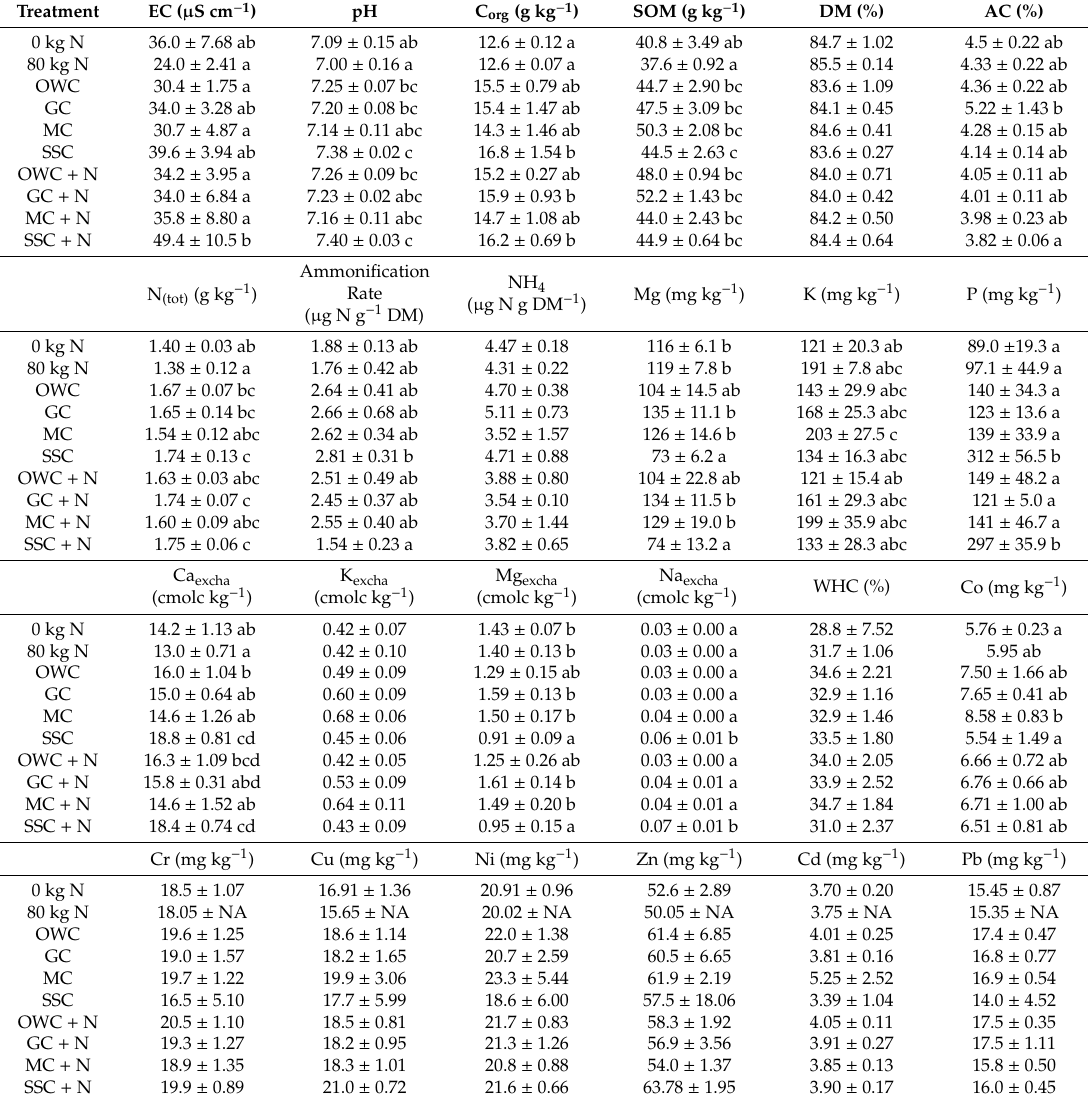
Table 2. Physicochemical soil parameters comparing di ff erent treatments (mean ± standard deviation, n = 4; for treatment, 80 kg N heavy metal contents were analyzed for only one soil sample).